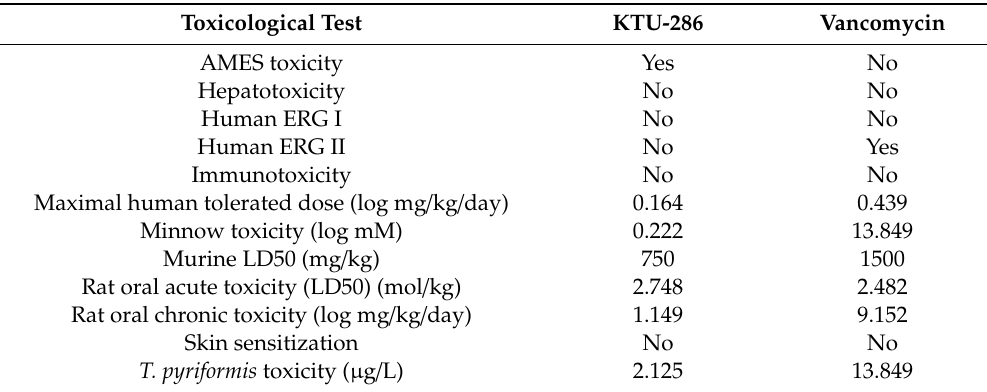
Table 4. The toxicological parameters of KTU-286 were predicted using ProTox and pkCSM software.